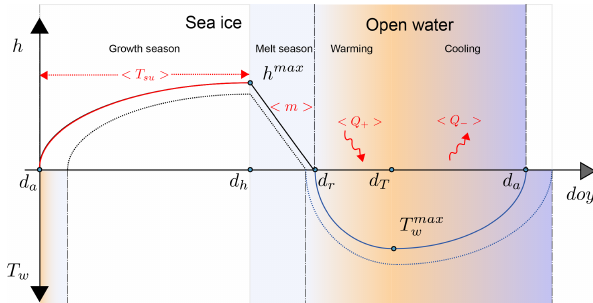
Figure A1. Schematic representation of the analysis framework applied to the 1-D model outputs, illustrating the mechanisms of change in ice seasonality between a reference year (solid line) and a subsequent year (dashed line). Ice appears at the ice advance date ( d a ) . The ice thickness ( h) increases until the date of maximum thickness ( d h ) , then decreases at an average melt rate (cid:104) m (cid:105) . Once the ice thickness vanishes at the ice retreat date d r , the sea water temperature T w increases due to incoming heat flux Q + , until the date of maximum temperature ( d T ) , and finally decreases due to the heat loss Q −